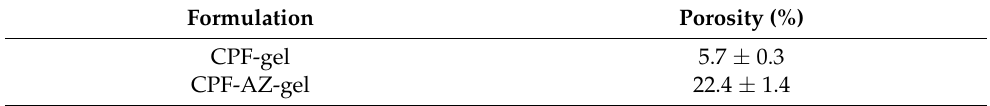
Table 2. Porosity of caspofungin-loaded gels.